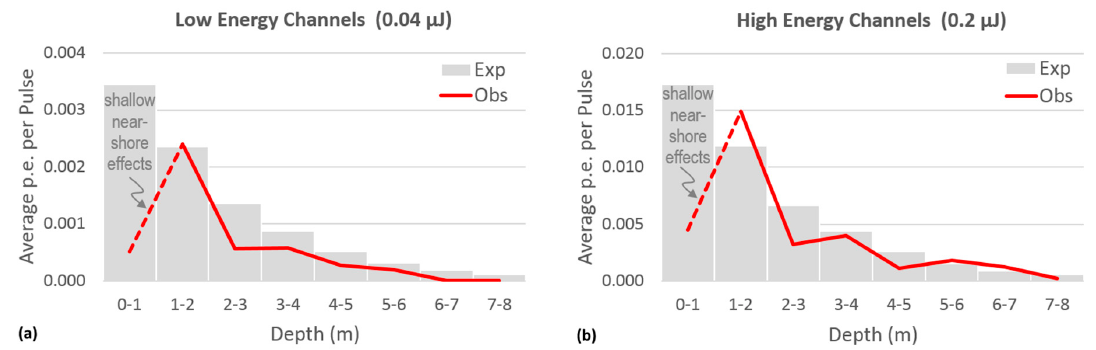
Figure 12. The average observed and expected numbers of photoelectrons (p.e.) are shown for the ( a ) low-energy and ( b ) high-energy channels. The results show good qualitative agreement between observed and expected numbers of p.e. in the 1–8 m depth range, but anomalous, shallow, near-shore effects in the 0–1 m depth range, which is typically challenging for bathymetric lidar mapping.